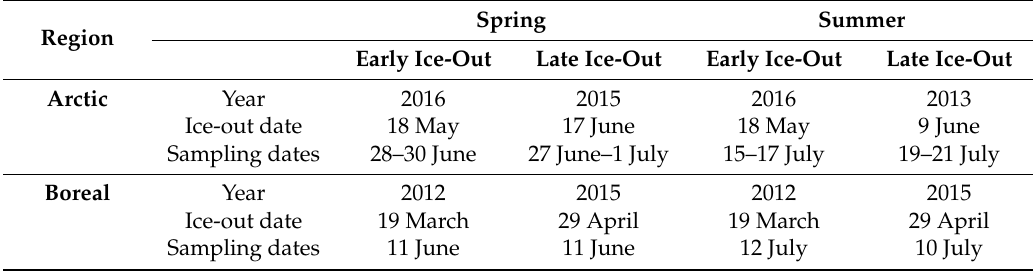
Table 1. Dates of comparison for early ice-out versus late ice-out years in Arctic and boreal ecosystems. Comparisons were also made in the late spring (denoted Spring) and in mid-summer during peak thermal stratification (denoted Summer). Range of dates for Arctic includes sampling at all three lakes.